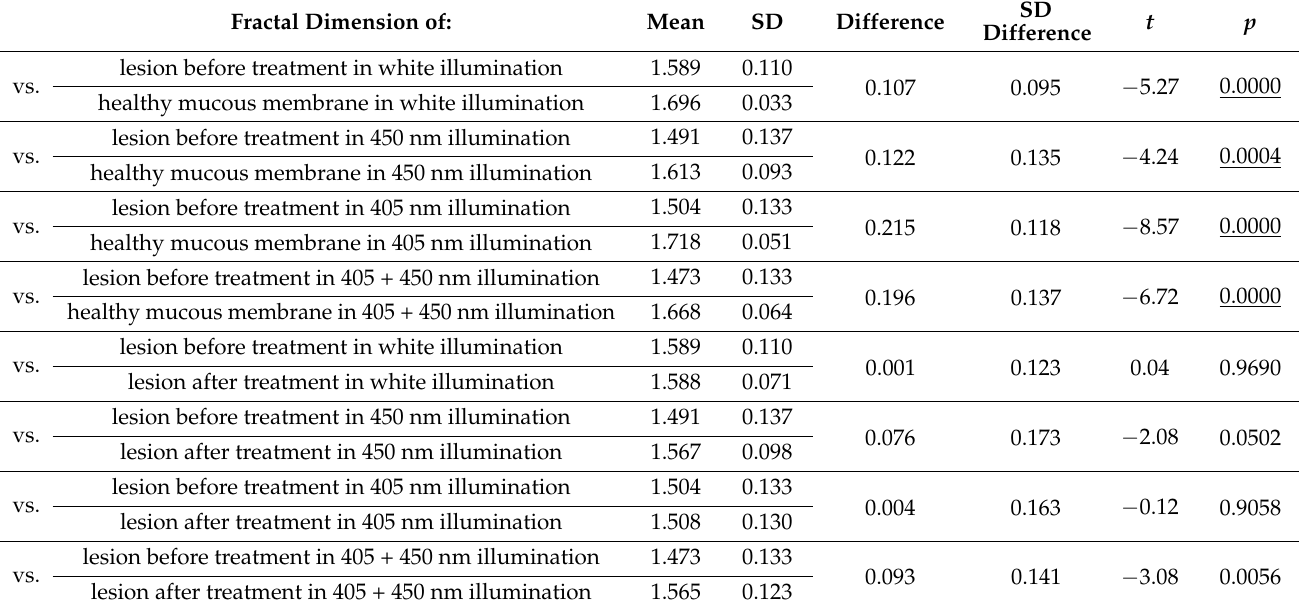
Table 5. Results of paired t -Student test. Comparison between fractal dimension of lesion before treatment and healthy mucous in various wavelength (white—full spectrum of light, 405, 450, 405 + 450 nm), comparison between fractal dimension of lesion before and after treatment in various wavelengths (SD—standard deviation, t —value of Student t -test, underlined— p <